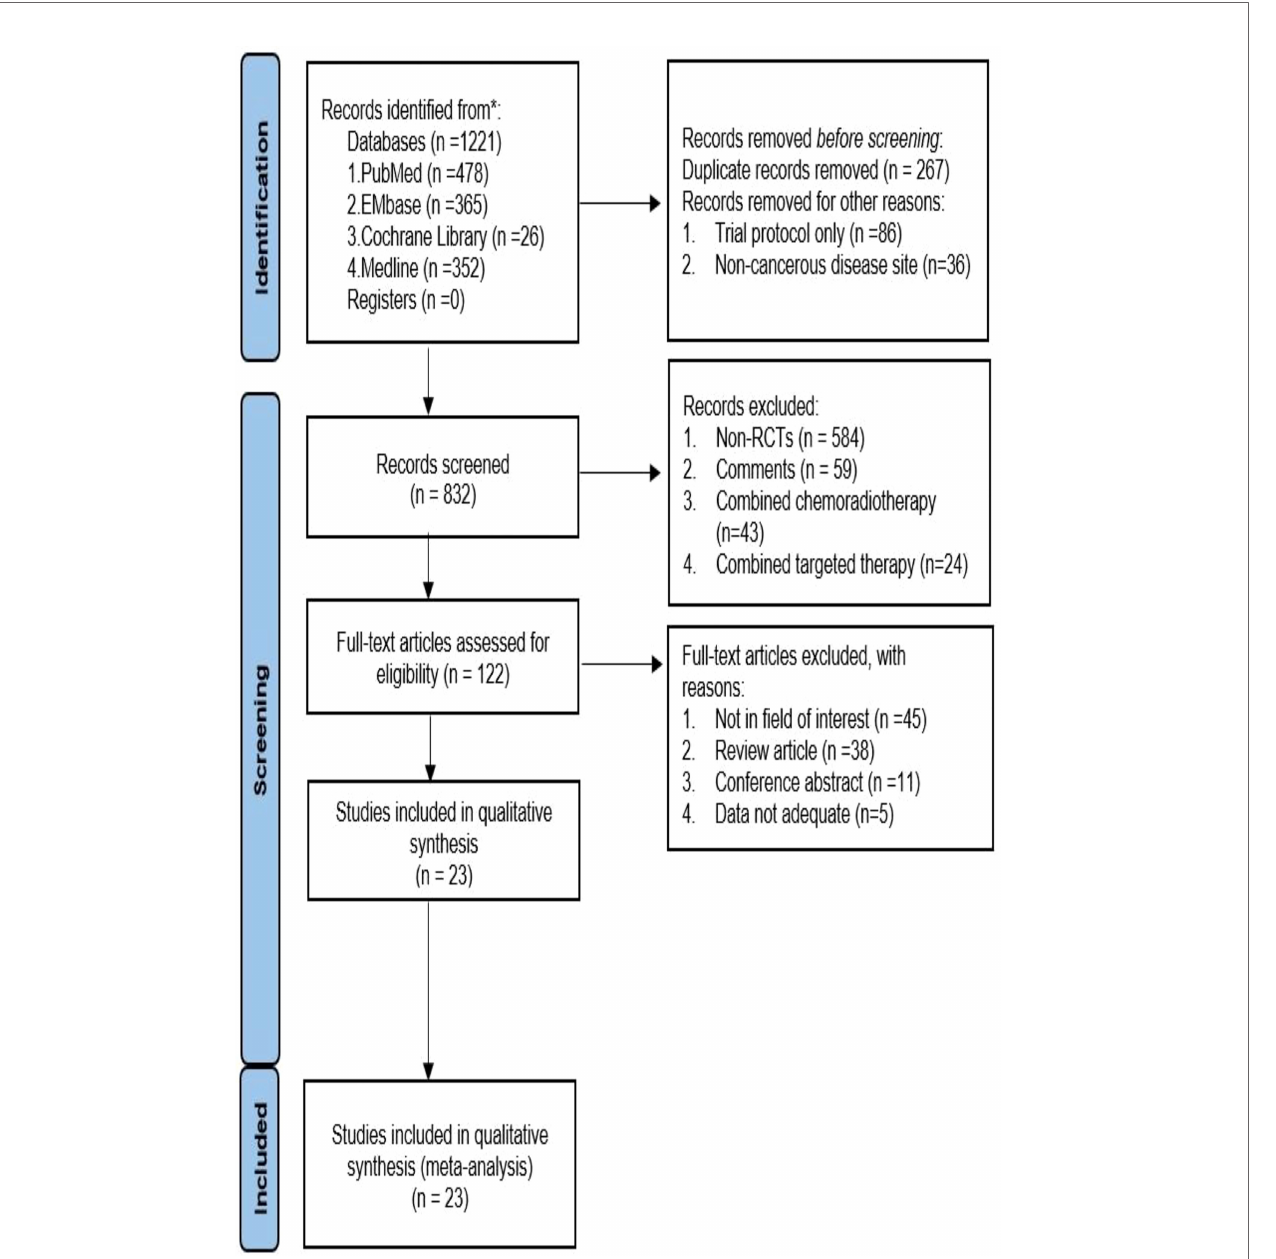
FIGURE 1 | PRISMA Flow